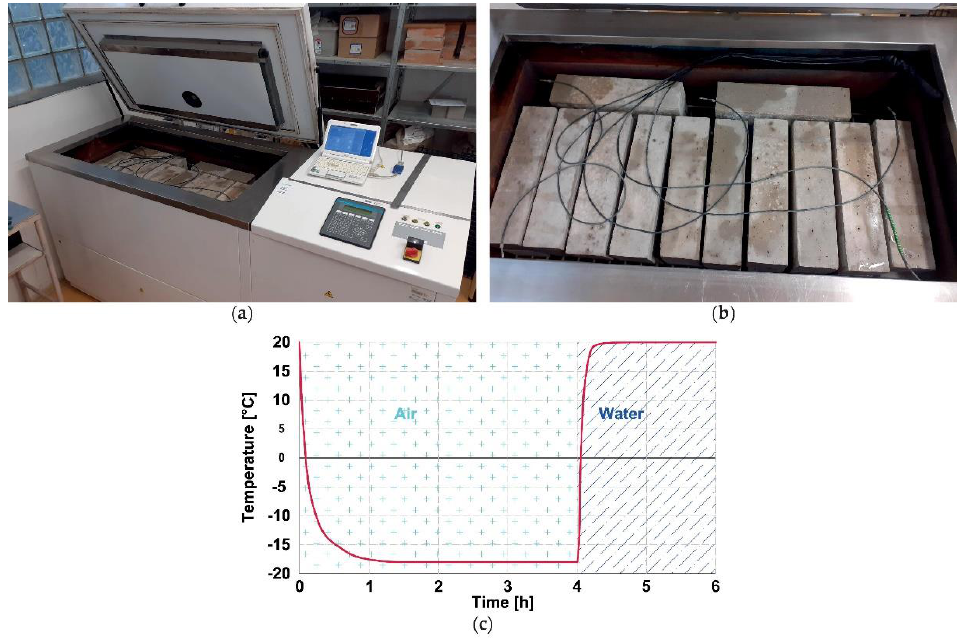
Figure 1. Arrangement of freeze–thaw test: ( a ) automatic freeze–thaw cabinet KD 20; ( b ) detail of specimens arrangement during F–T test; ( c ) one F–T cycle.